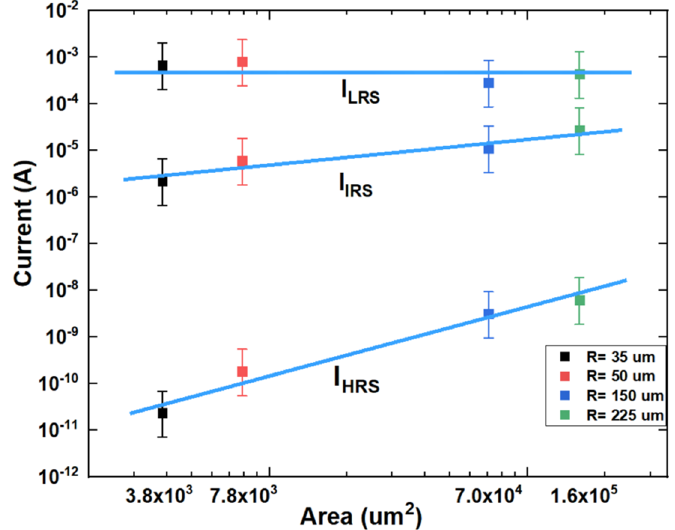
Figure 4. The area dependent current characteristics of Au/Ni/SiO x N y /p + -Si memory devices.